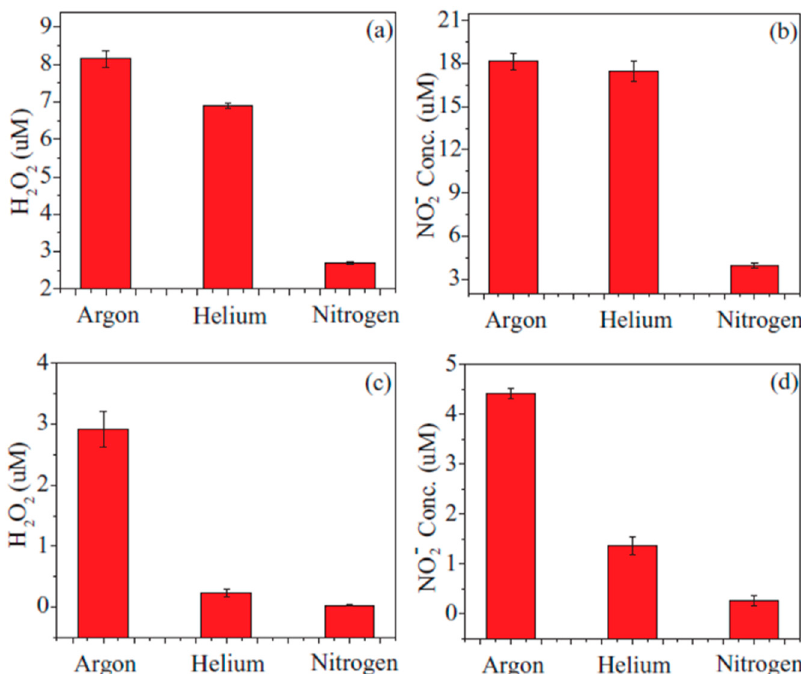
Figure 15. H 2 O 2 and NO 2 − concentration in plasma discharge generated in deionized water by Keidar et al. [249]; ( a , b ) correspond to plasma submerged in deionized water, while ( c , d ) correspond to plasma generated outside the water (water volume is 200 mL). Reprinted with permission from [249].